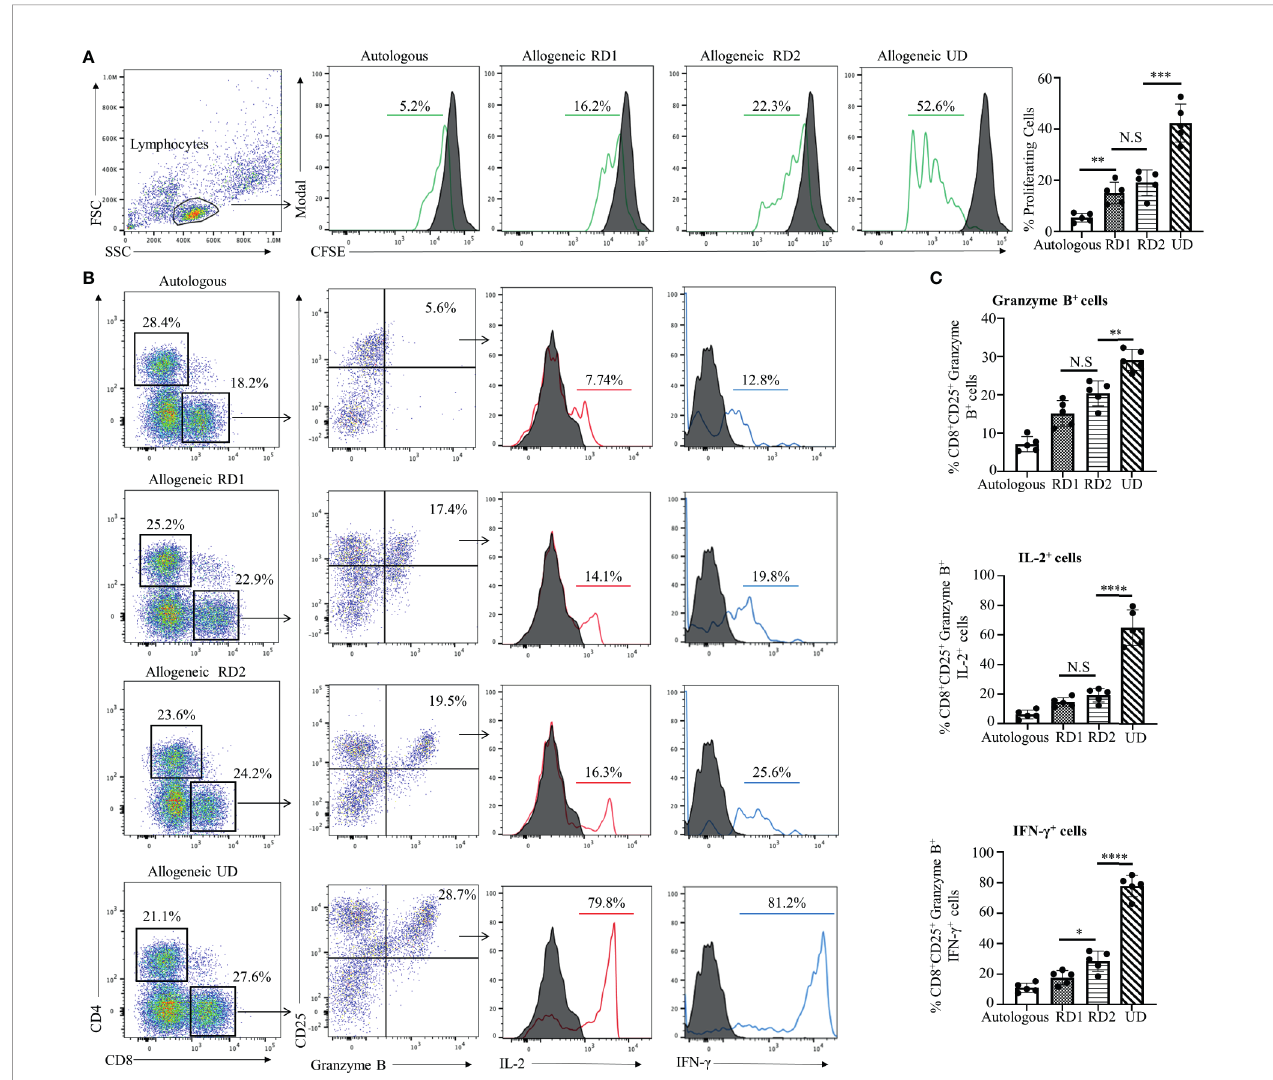
FIGURE 1 | Recipient ’ s allogeneic response generated in MLR was indistinguishable between RD1 and RD2 donors. (A) Representative fl ow cytometry histogram depicts CFSE-based proliferation of recipient cells in response to alloantigens from related (RD1, RD2) and unrelated (UD) donor stimulator cells. Filled histograms show CFSE-stained non-proliferating control, and green histograms show CFSE-stained proliferating cells. Graphical summary illustrates frequency (%) of proliferating recipient cells with each stimulator group. Data are representative of 5 separate experiments. Data presented as mean ± SD. ** p < 0.01, ***p < 0.001, NS., not signi fi cant. (B) Representative fl ow cytometry color plots depict gating strategy for the identi fi cation of CD25 + Granzyme B-expressing CD8 + T cells amongst the responding recipient cells in each stimulator group. Histogram illustrates expression of pro-in fl ammatory cytokines IL-2 (red line) and IFN- g (blue line) in the cytotoxic CD8 + CD25 + Granzyme B + cells. Filled histogram shows isotype control. (C) Graphical summary depicts frequency (%) of CD8 + CD25 + Granzyme B + cells. The IL-2 and IFN- g pro fi le of CD8 + CD25 + Granzyme B + in each stimulator group is depicted. Data presented as mean ± SD from 5 experiments. * p < 0.05, ** p < 0.01, **** p < 0.0001, NS., not signi fi